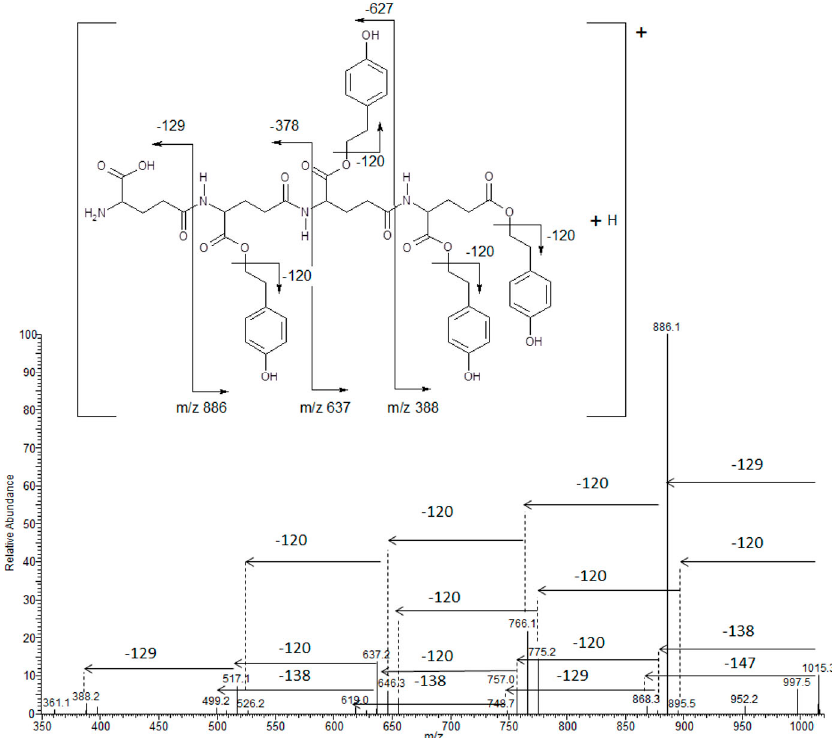
Figure 5. ESI-MS/MS product ion spectrum of the sodiated tyrosol- γ -PGA conjugate at m / z 1015 and theoretical fragmentation pathway of this ion.